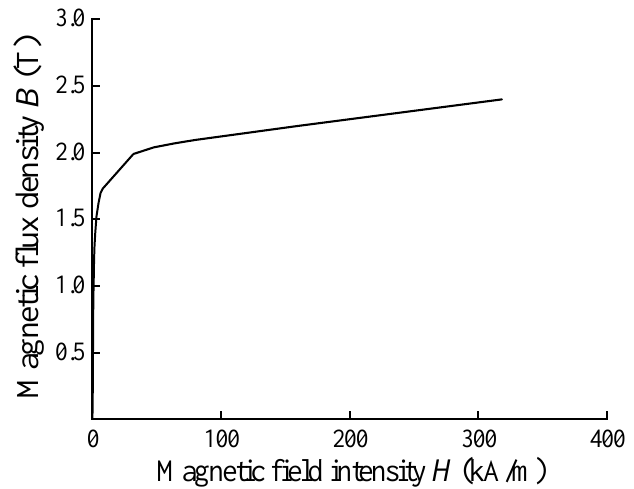
Figure 6. B - H curve of 10# steel.